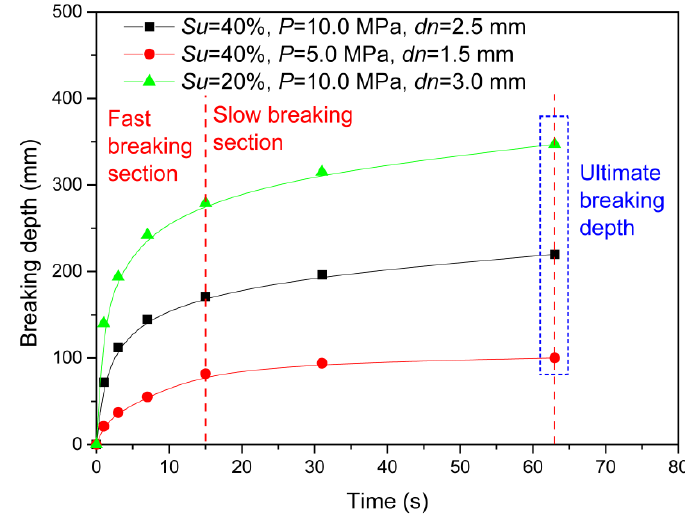
Figure 3. Variation of breaking depth with jetting time of water jet on NGH.